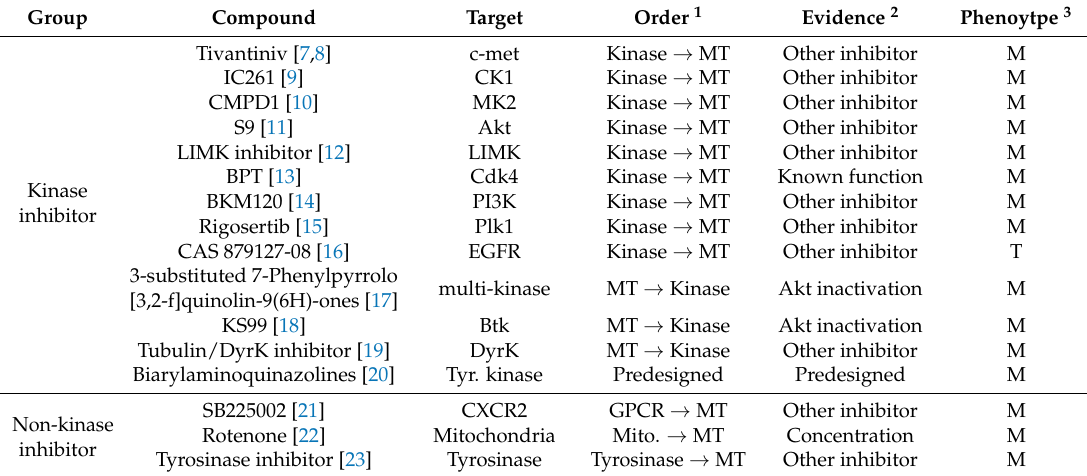
Table 1. List of dual inhibitors of microtubules and other